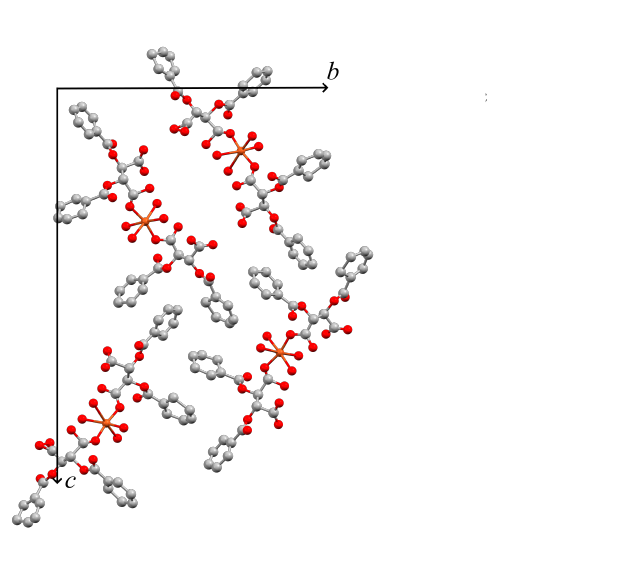
Figure 12. Unit cell of an incomplete preliminary structure model for 3b (Mercury [42], viewed along [1 0 0] direction; atoms shown as spheres with fixed radius).